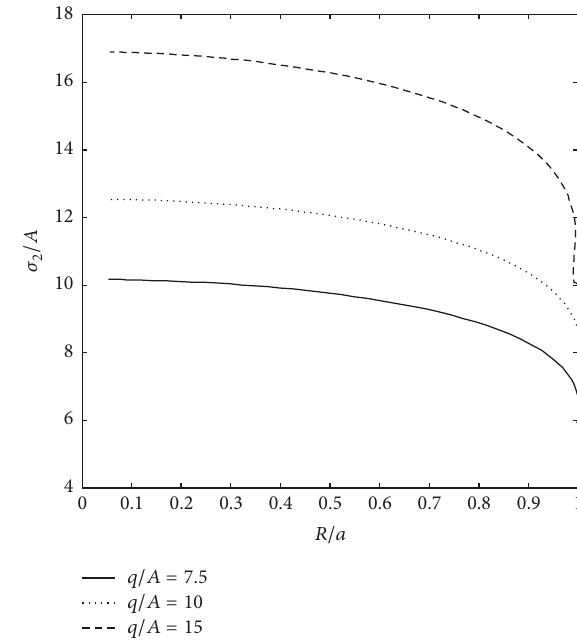
Figure 6: The circumferential stress distribution curve on mem- brane ( 𝑛 = 2 ; 𝛼 = 1